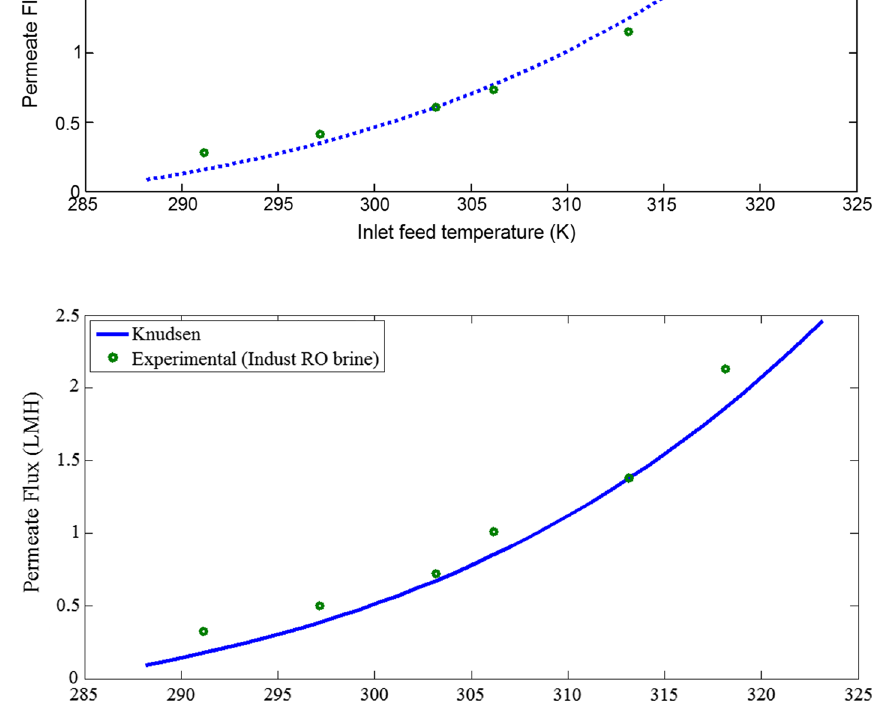
Fig. 10 A comparison between the transition flow model and experimental results for spent ion exchange regenerant